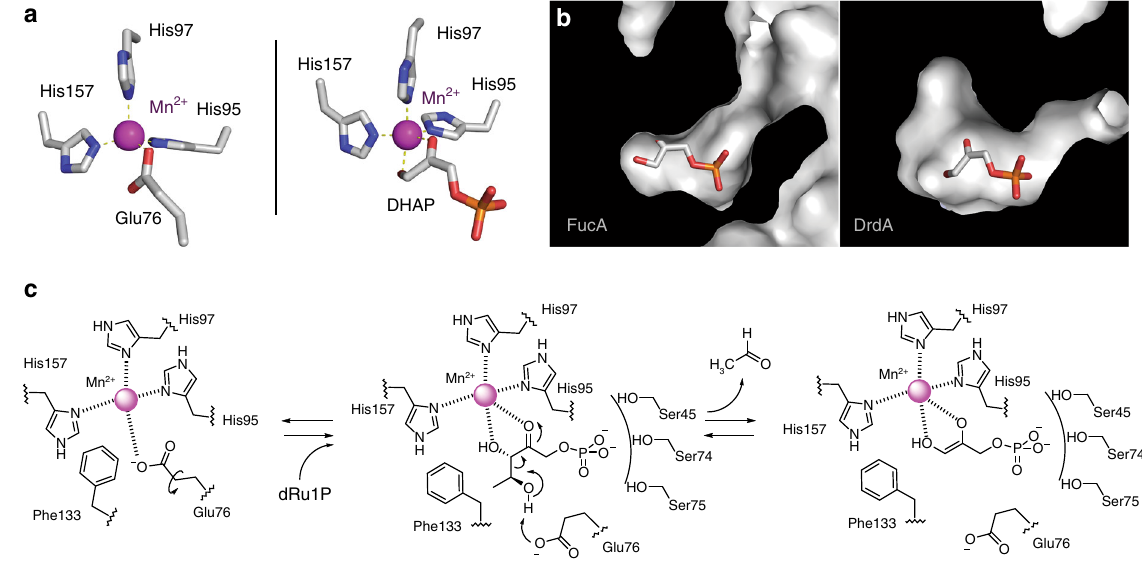
Fig. 5 Substrate/metal binding and proposed enzymatic mechanism of DrdA. a Manganese binding coordination of unliganded and liganded DrdA; the substrate DHAP replaces the coordinating Glu76. b Active site surface representation showing the binding pocket for the acceptor, aldol substrate in DrdA and FucA (PDB code 4C24). c Mechanistic proposal for DrdA-catalyzed formation of the enediol intermediate along with release of